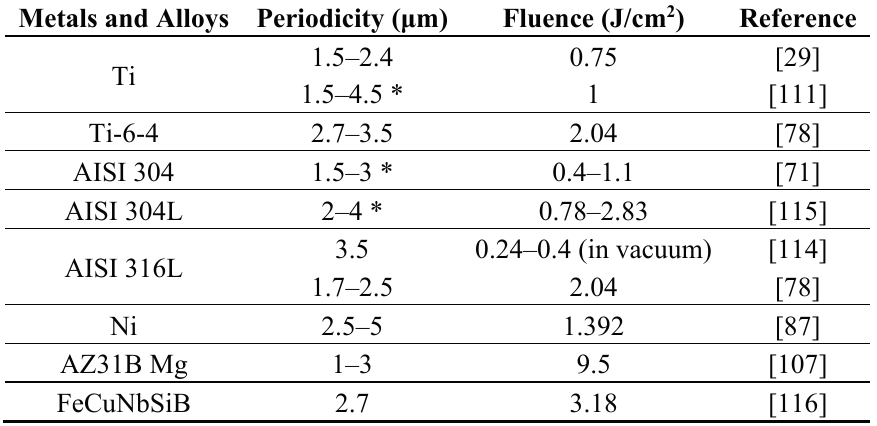
Table 4. Characteristics of undulating grooves and columnar structures on different metals and alloys. * Values are estimated from the SEM